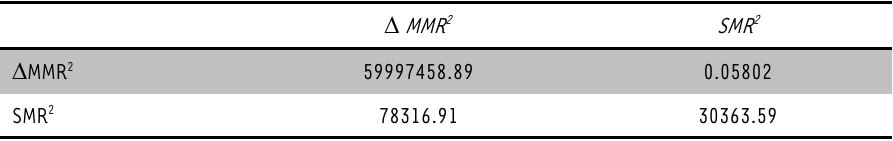
TABLE 3: Money and Stock Markets Returns Covariance